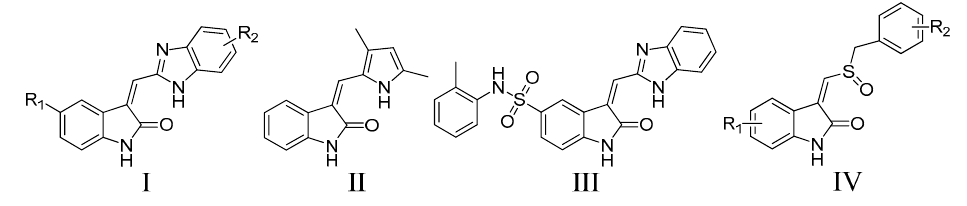
Figure 1. Chemical structures of I , II , III and IV .